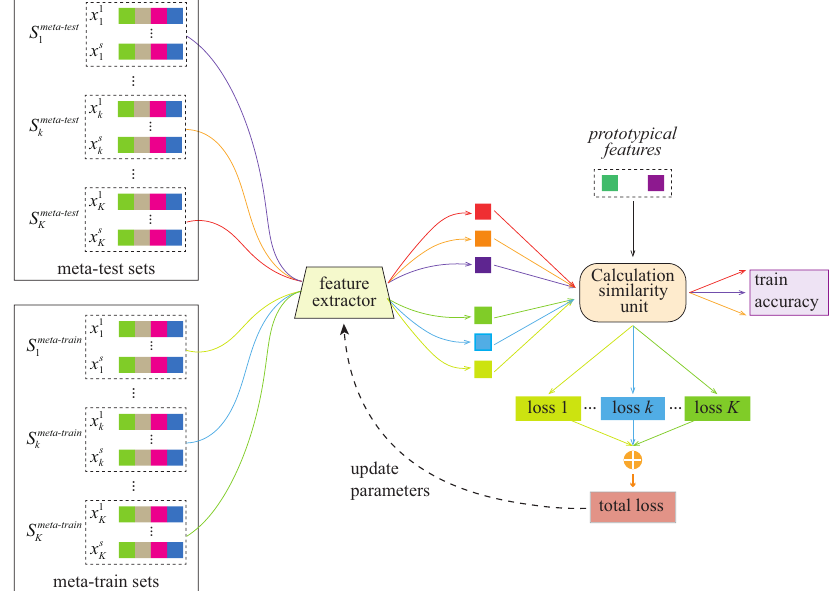
Figure 4. Training flowchart of the Siamese network. The prototypical features are extracted from the baseline